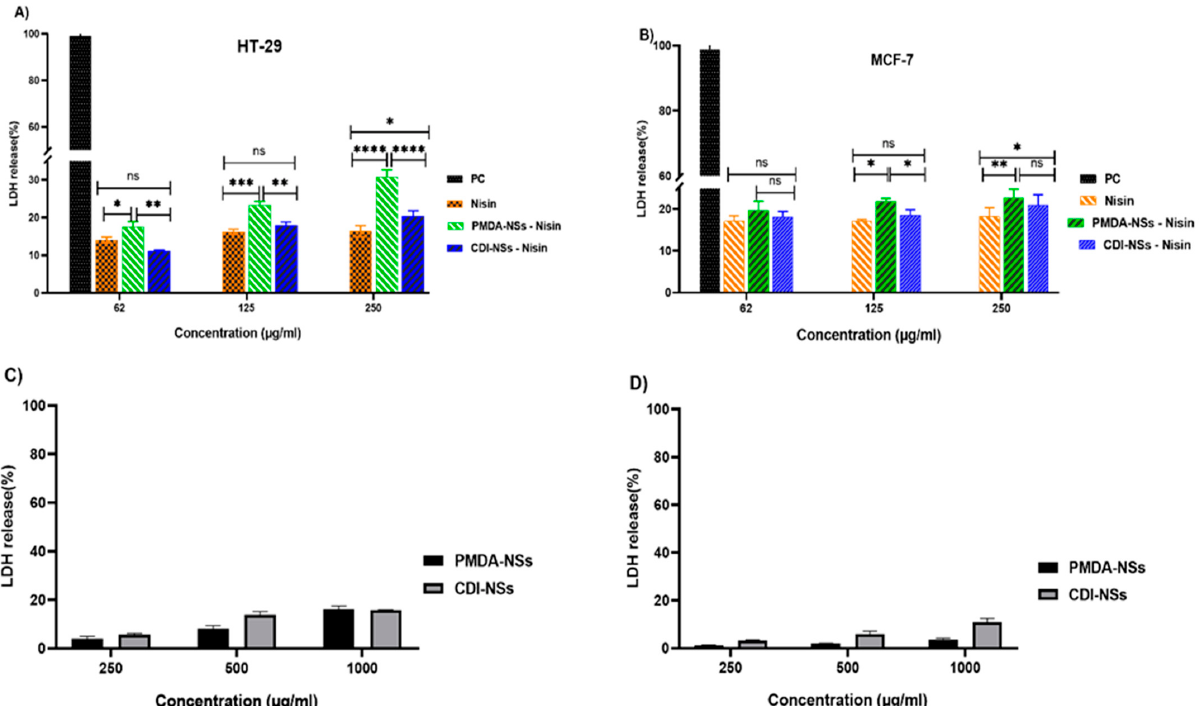
Figure 7. LDH release from HT-29 and MCF-7 cells following treatment with free Nisin Z and loaded on nanosponges ( A , B ) and plain nanosponges ( C , D ) for 24 h. Results are expressed relative to the untreated control and the maximum release sample (Positive Control (PC)), which was set as having 0 and 100% LDH release, respectively. Data are expressed as mean ± SD ( n = 3). Two-way